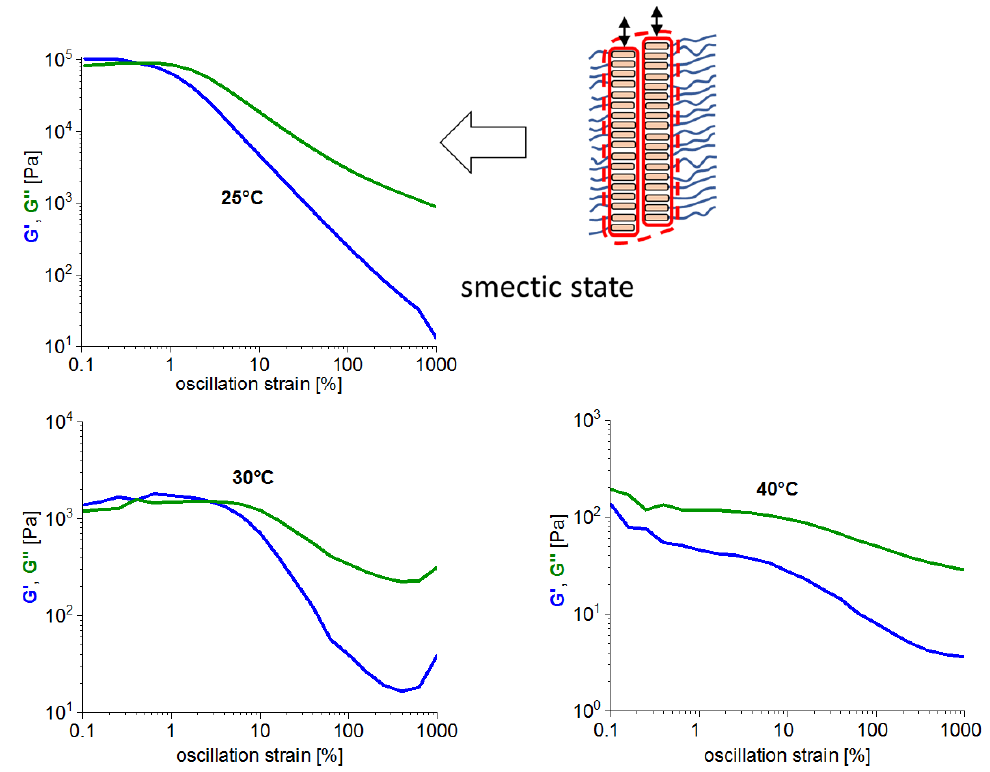
Figure6. DisconnectionofthephysicalcrosslinksinH03–BAFKU 2 bymechanicalstrain: strain-dependence Figure 6. Disconnection of the physical crosslinks in H03–BAFKU 2 by mechanical strain: strain- of storage ( G (cid:48) ) and loss ( G ”) modulus of H11–BAFKU 2 at temperatures from + 25 to + 40 ◦